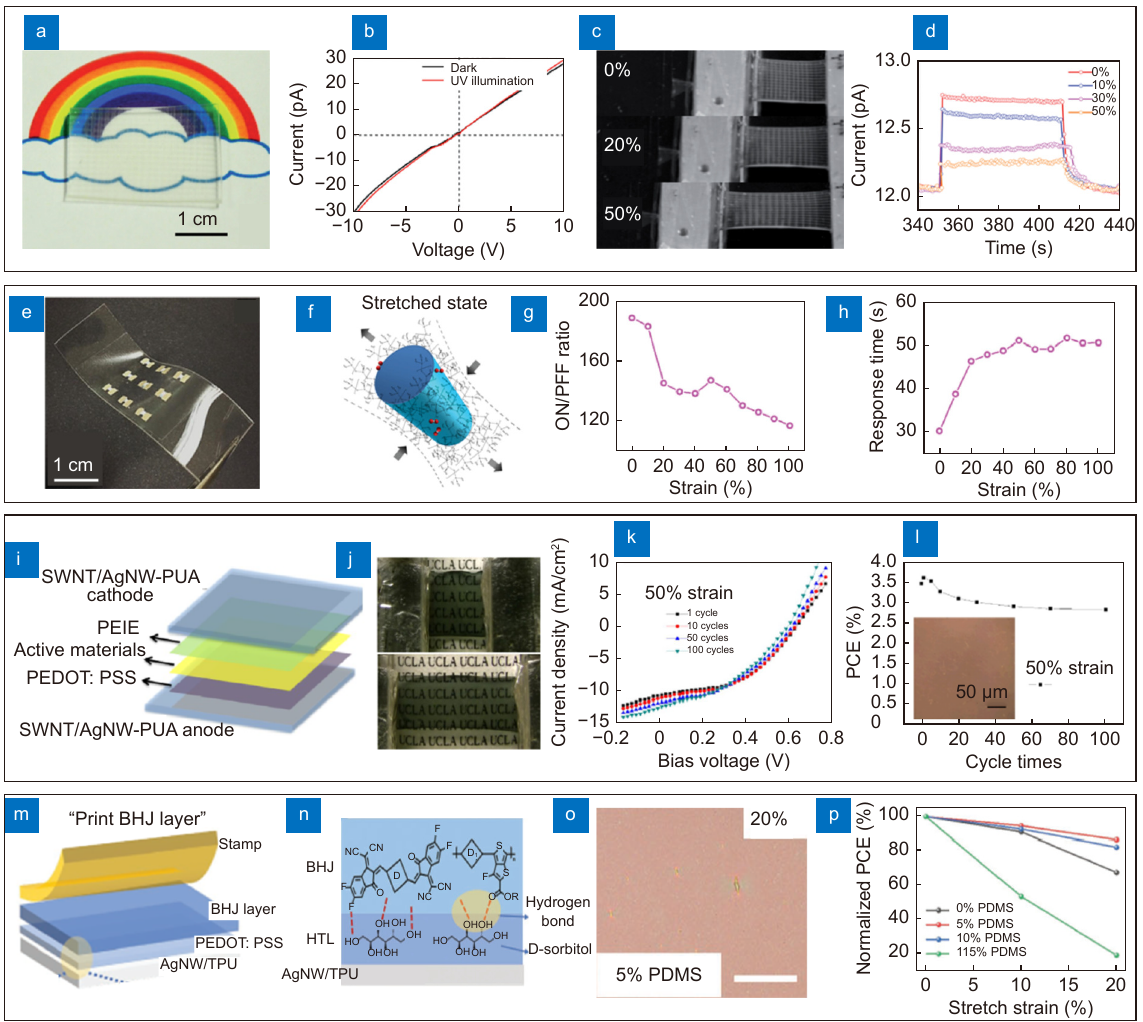
Fig. 10 | PDs and PVs with intrinsic stretchability. ( a ) Photograph of the intrinsically stretchable PD based on Zn 2 SnO 4 NW/PDMS composite and Ag NW electrodes. ( b ) Current-voltage characteristic of the PD. ( c ) Photographs of the PD during stretching with different strains. ( d ) Photoresponses of the PD with respect to applied strains with different amounts. ( e ) Photograph of the intrinsically stretchable PD based on ZnO NW/PDMS composite and Ag NWs. ( f ) Schematic showing the effect of stretching on the NW surface. Changes in ( g ) on/off ratio and ( h ) re- sponse time of the PD array at different stretching strains. ( i ) Structure of intrinsically stretchable solar cell based on SWCNT/Ag NW-PUA com- posite electrodes and (PTB7)/PC 71 BM photo-absorbing layer. ( j ) Photographs of the solar cell before and during stretching. Stability of the stretchable solar cell in terms of ( k ) J - V characteristics and ( l ) PCE during stretching. ( m ) Structure of the intrinsically stretchable solar cell based on Ag NW/TPU composite electrodes and PTB7-Th:IEICO-4F heterojunction film. ( n ) Schematic showing the adhesion of photo-absorbing layer and HTL. ( o ) Optical image of the photo-absorbing layer under 20% strain. ( p ) PCE of the solar cell during stretching. Figure reproduced with per- mission from: (a–d) ref. 178 , The Royal Society of Chemistry; (e–h) ref. 179 , John Wiley and Sons; (i–l) ref. 180 , American Chemical Society; (m–p) ref. 165 , John Wiley and